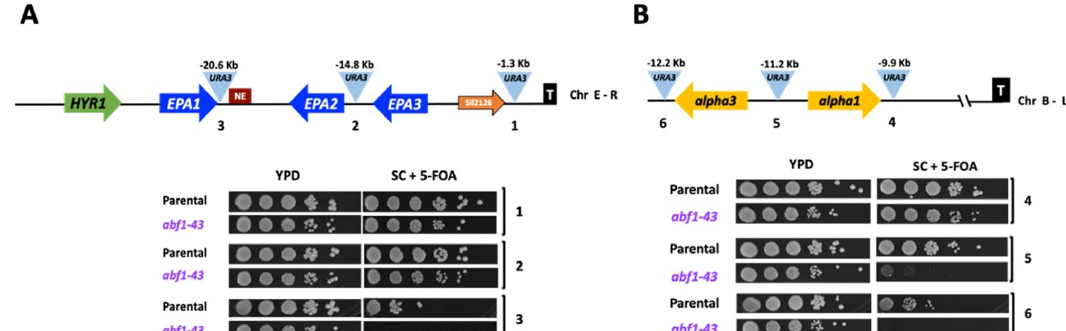
Figure 7. Abf1 plays a role in silencing at different subtelomeric regions in C. glabrata. ( A ) Schematic representation of the subtelomeric region of the Chr E-R in C. glabrata . The light blue triangles represent the position of three independent insertions of the URA3 reporter, and the distance from the telomere is indicated above each insertion. The numbers beneath the triangles correspond to the insertions carried by each strain in the plate growth assay below. 5 µ L of ten-fold serial dilutions of cells grown to stationary phase were spotted onto the media indicated, incubated at 30 ◦ C for 48 h, and photographed. ( B ) Schematic representation of the subtelomeric region of Chr B-L. Yellow arrows represent alpha3 and alpha1 genes at the MTL3 silent locus and their relative orientation at the Chr B-L. The numbers below the insertions correspond to the numbers in the plate growth assay as in Figure 7A. The experiments were performed three independent times, and photographs from a representative experiment are shown (see in Section 2.10).